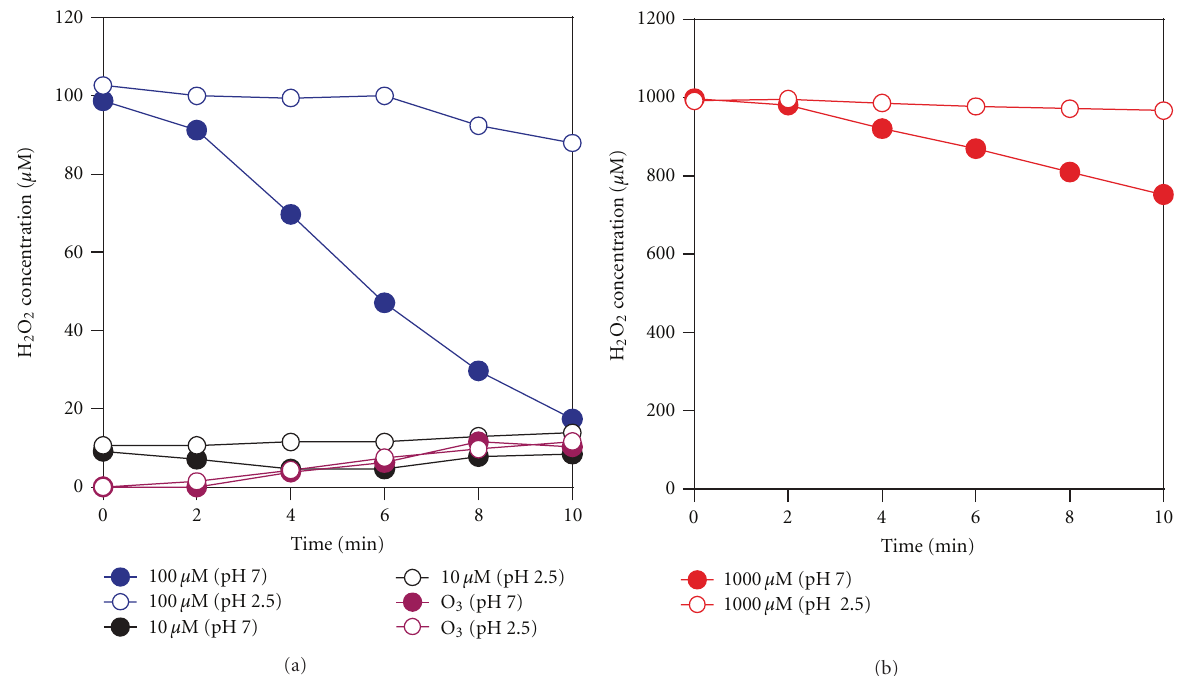
Figure 6: Changes in H 2 O 2 concentrations during O 3 /H 2 O 2 and ozonation without 4-CBA. The concentrations in the legend mean the H 2 O 2 dose in O 3 /H 2 O 2 .